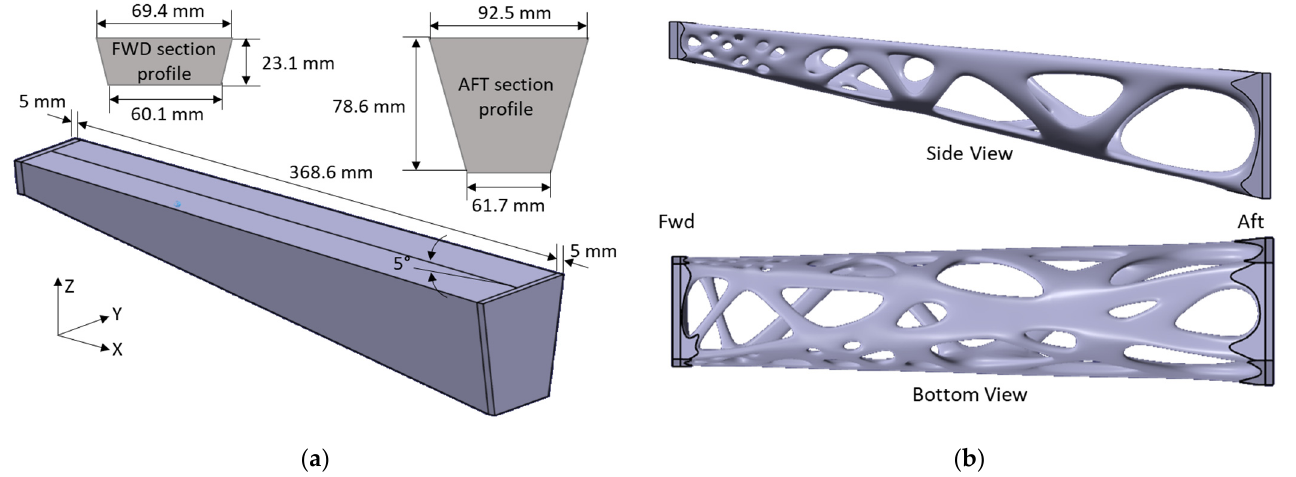
Figure 4. Macro-scale dimensional accuracy specimen design illustrating the: ( a ) design space dimensions; and ( b ) the final overall shape of the tapered box beam design showing the side view and bottom view.